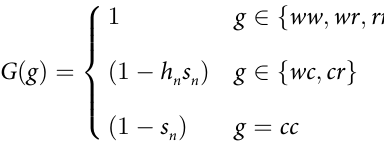
, g , g 0 ), with probability of occurrence given by the number in parentheses, where allele proba- M F